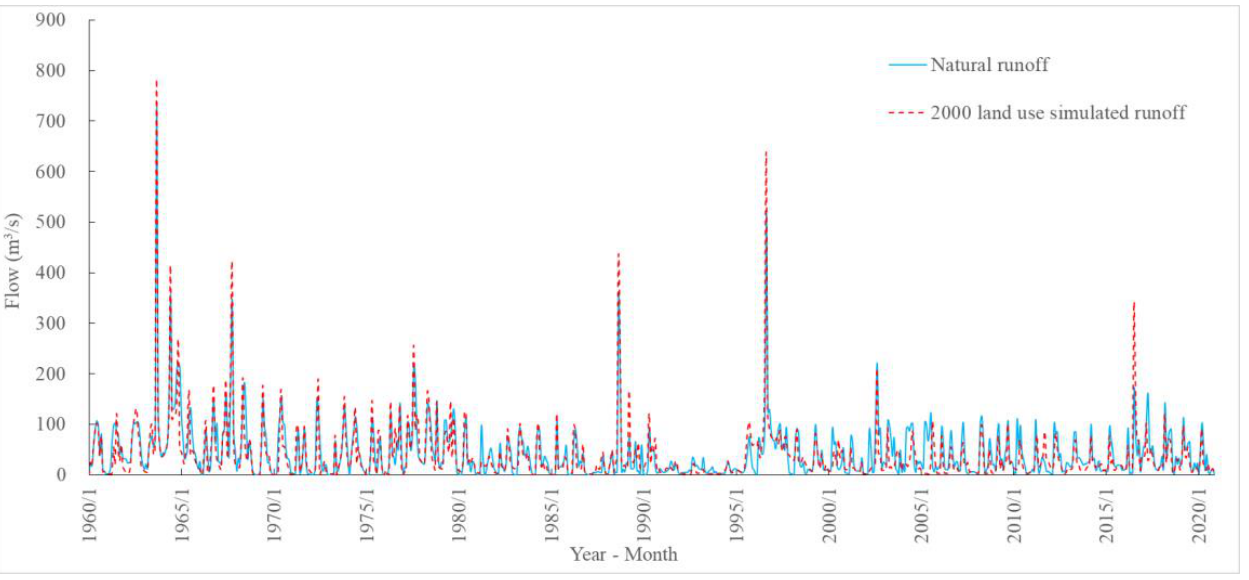
Figure 6. Comparison of simulated and natural runoff under the land-use scenario of 2010 at the Huangbizhuang Station.